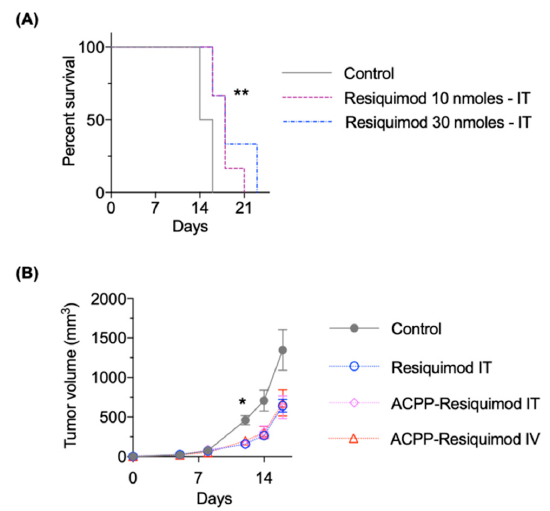
Figure 6. Antitumor efficacy of ACPP conjugated resiquimod. ( A ) Mice with B16 tumors intra- tumorally (IT) injected with free resiquimod. Mouse survival plotted and statistical significances calculated using Log-rank (Mantel–Cox) test. ( B ) Mice with B16 tumors treated IT with free re- siquimod or ACPP conjugated resiquimod given IT or intravenously (IV). Tumors measured twice a week and plotted as mean tumor volume ± SEM. Statistical significances calculated using two-way ANOVA. * p < 0.05, ** p <